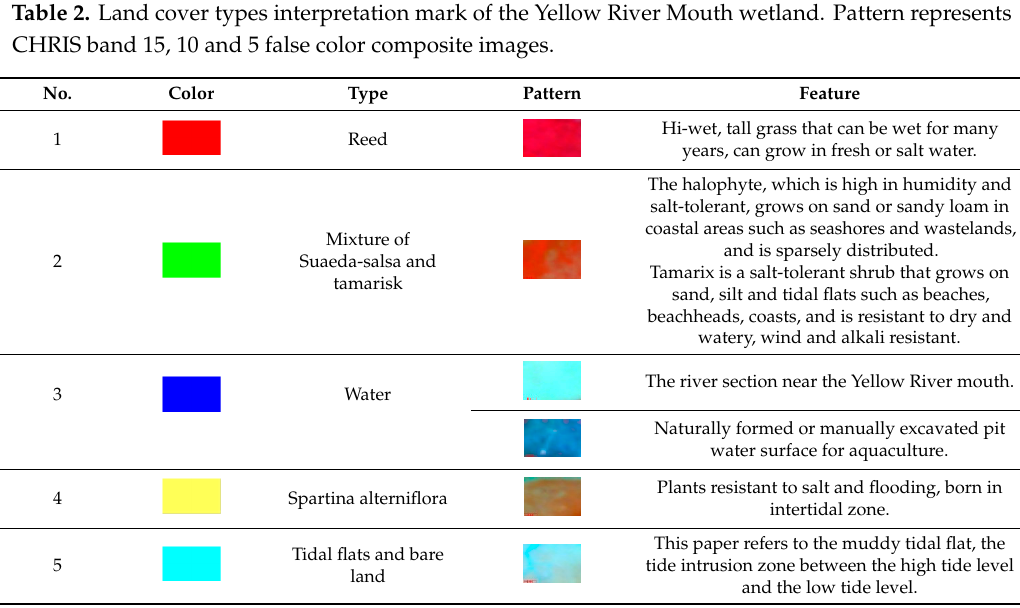
Figure 1. Study area data, ground truth and interpreting reference data. ( a ) False color image composite (band 15, 10 and 5); ( b ) ground truth image; ( c ) supplementary data (ZY-3 remote sensing image).